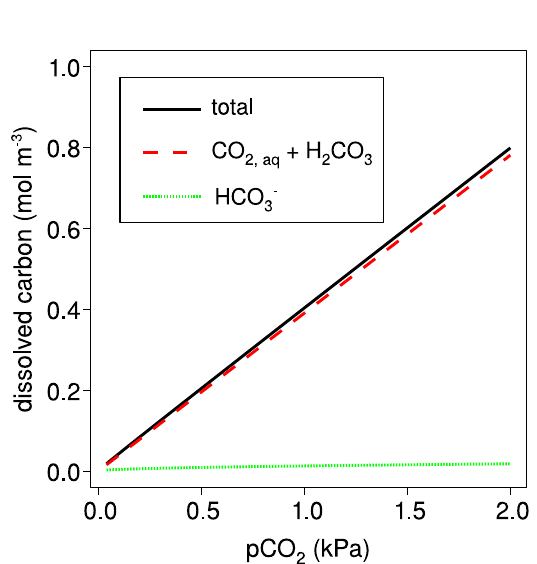
Fig. 1. Molar carbon concentrations of the different dissolved carbon species in a “ H 2 O - CO 2 ” -system (system b) as a function of the CO 2 partial pressure for T = 293 K . CO 2 , aq is the “physically” dissolved CO 2 .